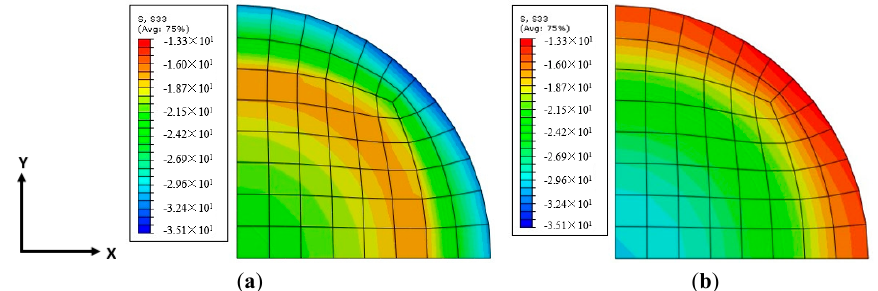
Figure 18. Axial stress distribution in the horizontal section (X-Y section) of specimen S-2-3-30 ( ε h,frp = 1.5%). ( a ) Mid-plain of each FRP strip; ( b ) Mid-plain of two adjacent FRP strips.